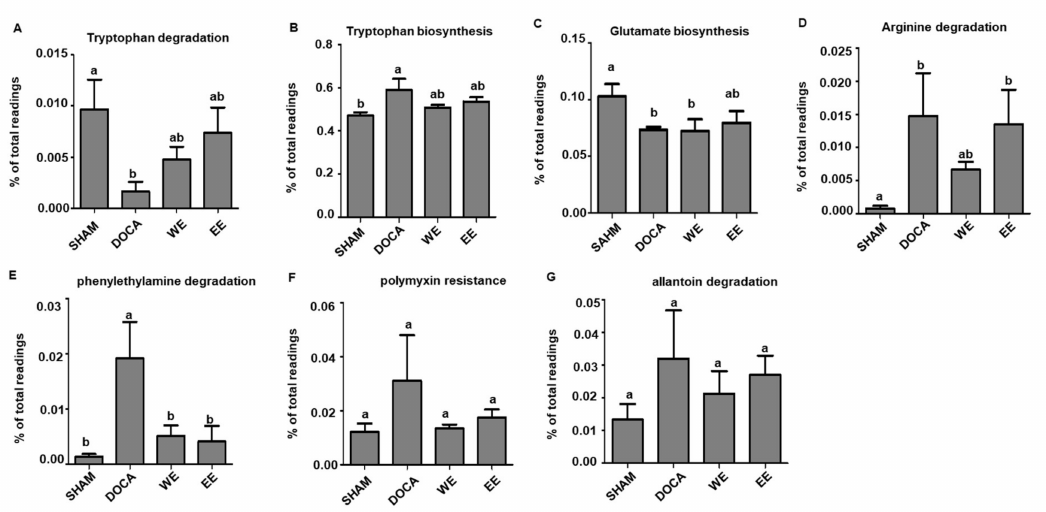
Figure A5. Effect of water extract and ethanol extract of L. rhamnosus AC1-fermented soymilk on predicted functions of gut microbiota in DOCA-salt hypertensive rats at week 14. Relative abundance of bacteria involved in tryptophan degradation ( A ), tryptophan biosynthesis ( B ), glutamate biosyn- thesis ( C ), arginine degradation ( D ), phenylethylamine degradation ( E ), polymyxin resistance ( F ) and allantoin degradation ( G ) are shown. Data are presented as means ± SEM ( n = 4). Bar values bearing different letters were significantly different by Duncan’s multiple range test ( p <